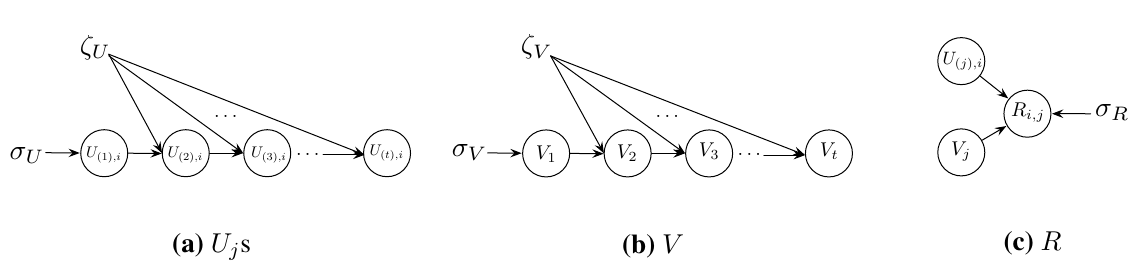
Figure 1. The structure